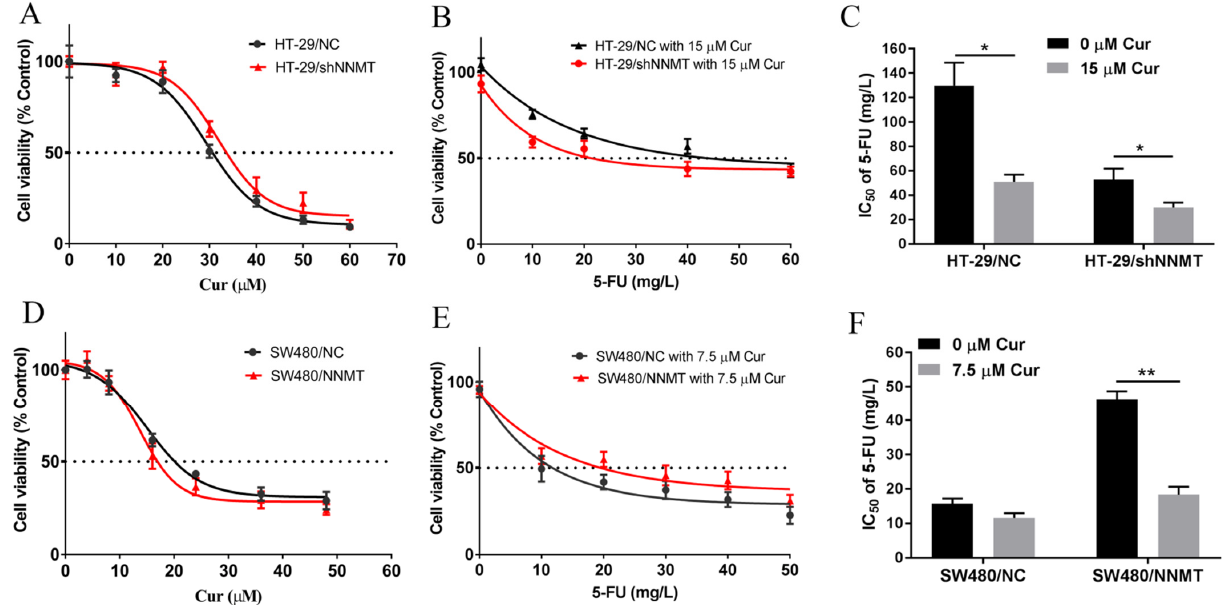
Figure 1. Cur inhibits CRC cell growth and attenuates NNMT-induced resistance to 5-FU. ( A , D ) CCK-8 analysis of HT-29/NC, HT-29/shNNMT, SW480/NC, and SW480/NNMT cell viability following treatment with Cur for 24 h. ( B , E ) CCK-8 analysis of HT-29/NC, HT-29/shNNMT, SW480/NC, and SW480/NNMT cell viability following treatment with Cur combined with different concentrations of 5-FU for 24 h. ( C , F ) IC 50 of 5-FU when co-treated with or without Cur in HT-29/NC, HT-29/shNNMT, SW480/NC, and SW480/NNMT displayed as a histogram. 5-FU: 5-Fluorouracil, Cur: curcumin. Data are expressed as means ± SD, n = 3, * p < 0.05, ** p < 0.01. Table 1. IC 50 of 5-FU in CRC cell lines. The concentrations of Cur are 15 μ M for HT-29 cell lines